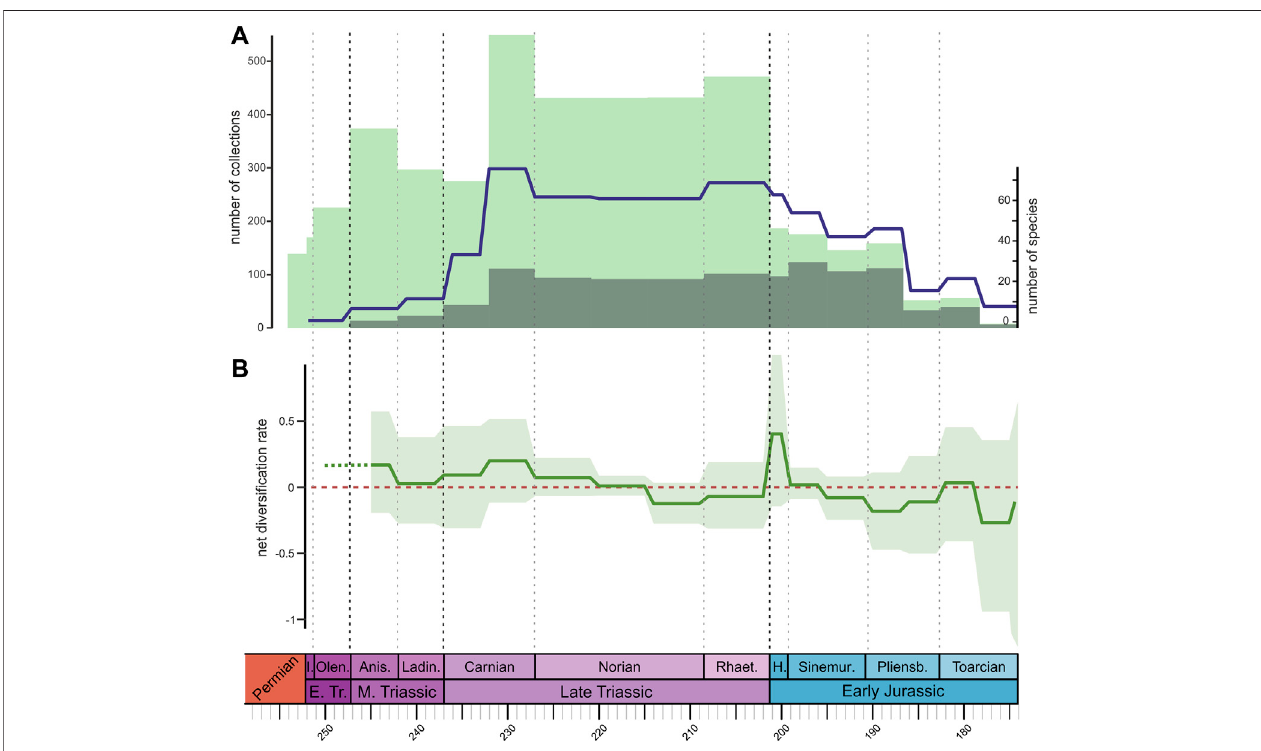
FIGURE 2 | (A) Through-time taxic richness of Triassic to Early Jurassic terrestrial Pan-Aves (solid blue line). Light green bars represent the number of PBDB collections bearing terrestrial tetrapods, whereas dark green bars represent PBDB collections with Pan-Aves (excluding pterosaurs). (B) Net diversi fi cation rates estimated from occurrencedatausing PyRate.Solidgreenlinerepresentsmeanvalues;lightgreenshaderepresentsmaximumand minimumratevaluesconsidering all ten replicates of the dataset. Results for the time-variable Poisson process (TPP) preservation model, using the “ site-unlinked ” occurrence dataset. Timescale abbreviations: as in Figure 1